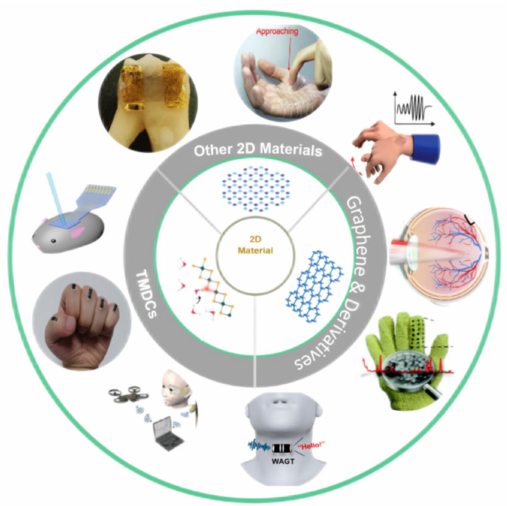
Figure 1. The representing sets of bio-integrated wearable sensors with 2D